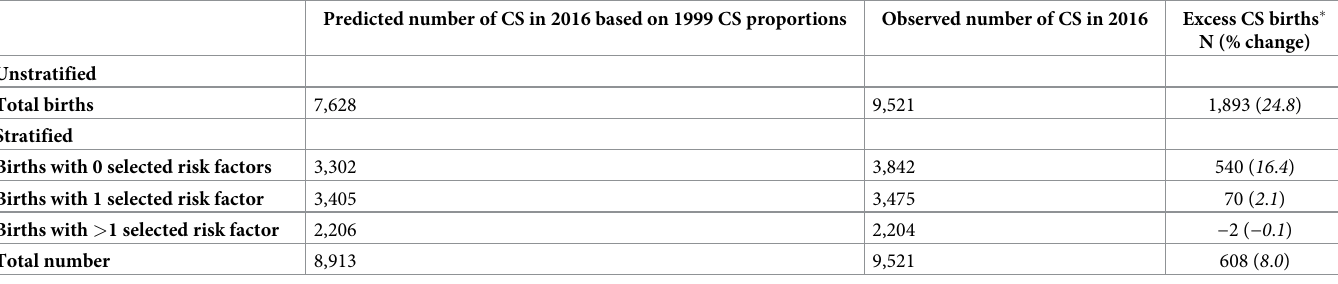
Table 3. Difference in predicted and observed values of CS births in 2016 based on proportions in 1999. Predicted number of CS in 2016 based on 1999 CS proportions Observed number of CS in 2016 Excess CS births �